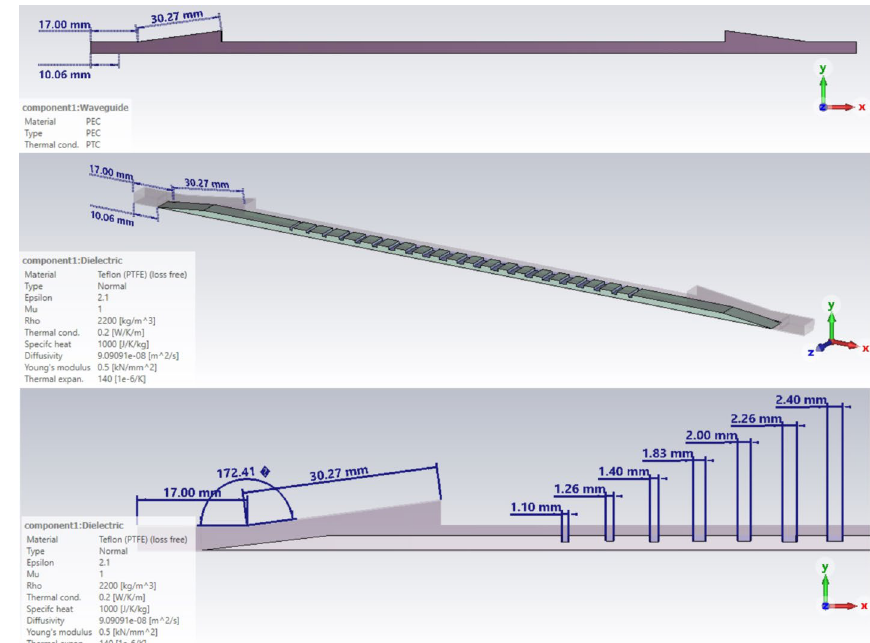
Fig. 5 Antenna simulation model (geometry with one-sided excitement, number of elements 21, dimensions of waveguide 7.2 × 3.6